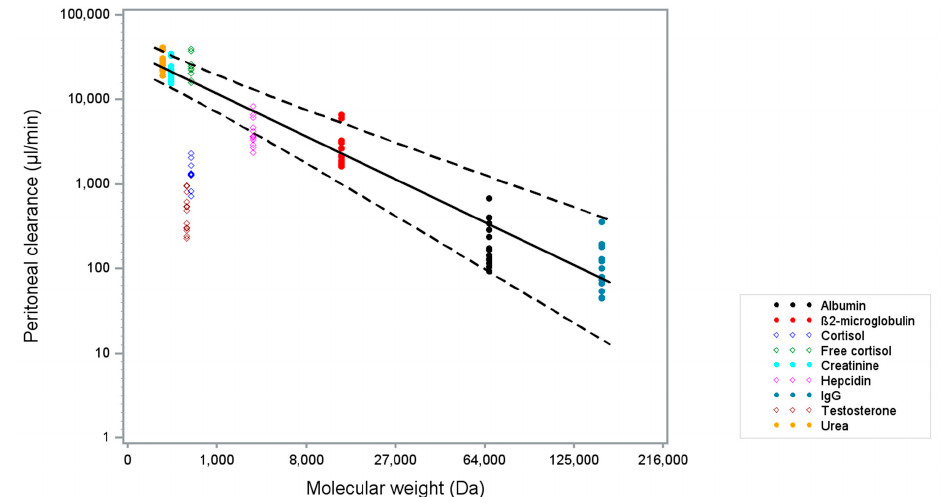
Figure 1. Peritoneal clearances (µL/min) as a function of molecular weight (Da). The logarithmically transformed peritoneal clearance (y-axis) of each specific analyte for each patient was plotted against the cube root of their molecular weight (x-axis). Based on the known free circulating analytes, i.e., urea, creatinine, β 2-microglobulin, albumin, and IgG (solid dots), a curve was established describing the relation between clearance and molecular weight (solid line) with a 95% prediction interval (dashed lines). Hepcidin, free cortisol, total cortisol, and total testosterone measurements (open dots) were plotted in the figure thereafter.